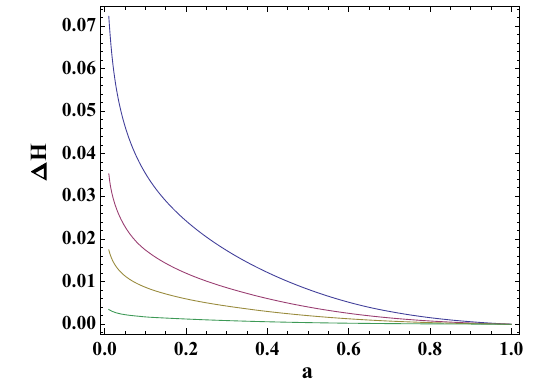
Fig. 1 (cid:10) H is plotted against the expansion factor, a , for α = 50 , 100 , 200 , 1000 ( top to bottom ). Here (cid:10) H = ( H − H (cid:4) CDM )/ H (cid:4) CDM and a = 1 corresponds to the present epoch the Hubble parameter H ( z ) in our model from (cid:4) CDM